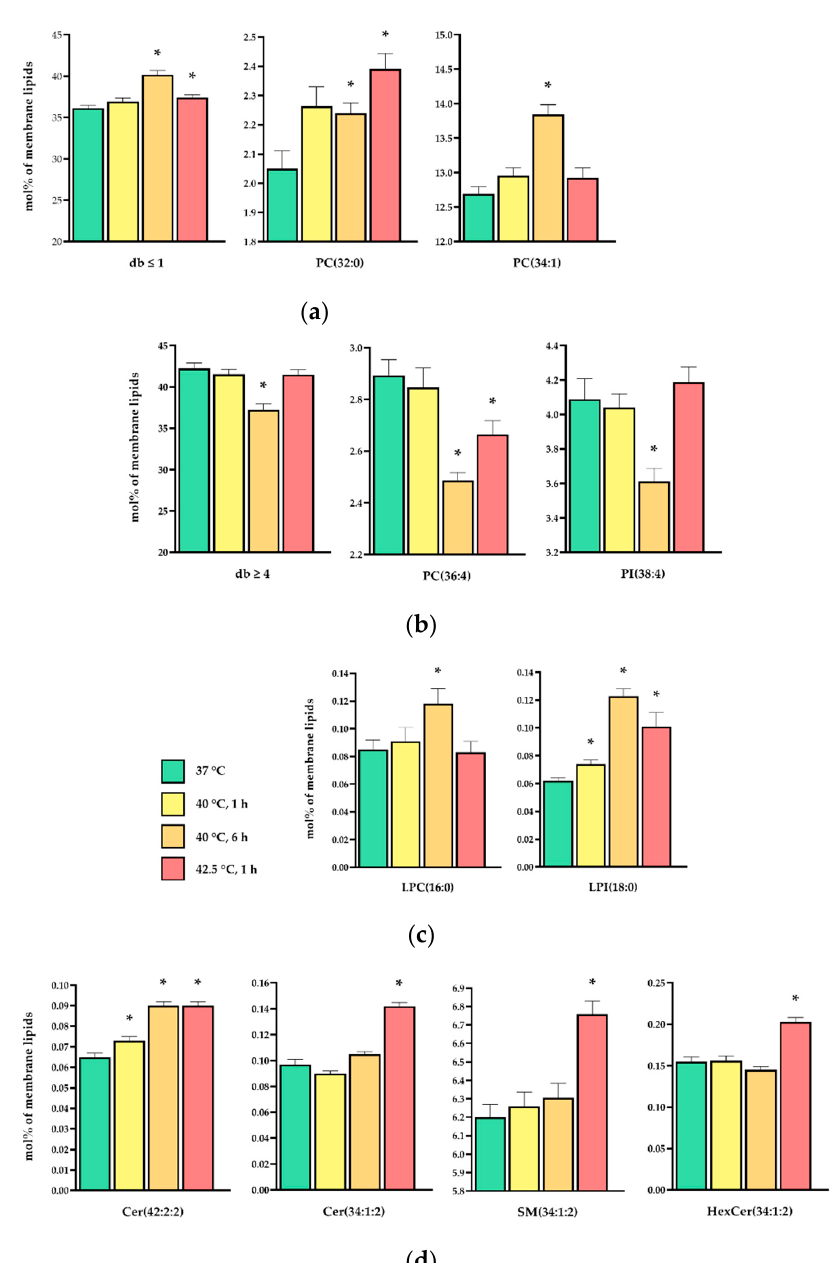
Figure 7. Heat-induced lipidomic changes. CHO cells were left untreated or subjected to 40 °C for 1 or 6 h or 42.5 °C for 1 h. ( a – d ) Changes in the relative concentration ( a ) of disaturated and monounsaturated membrane lipid species (db ≤ 1), ( b ) in polyunsaturated components (db ≥ 4), ( c ) in lysolipid species and ( d ) in sphingolipids. Data are expressed as mean ± SEM, n = 8; * denotes p < 0.025 compared to the untreated control. db, number of double bonds; PC, phosphatidylcholine; PI, phosphatidylinositol; LPC and LPI, the corresponding lyso species; Cer, ceramide; SM, sphingomyelin; HexCer, hexosylceramide.